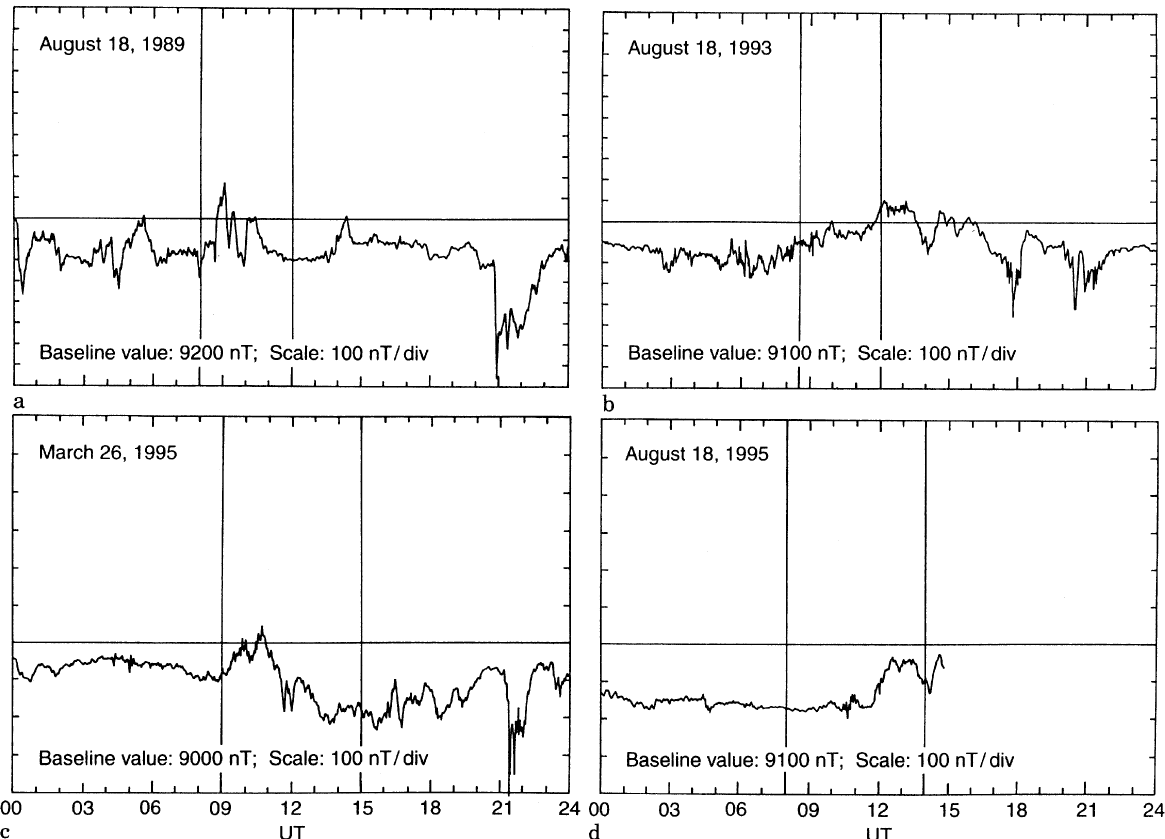
August 1995. Periods of observation are between the vertical lines. Note that the scale in c and d is different from that of a and